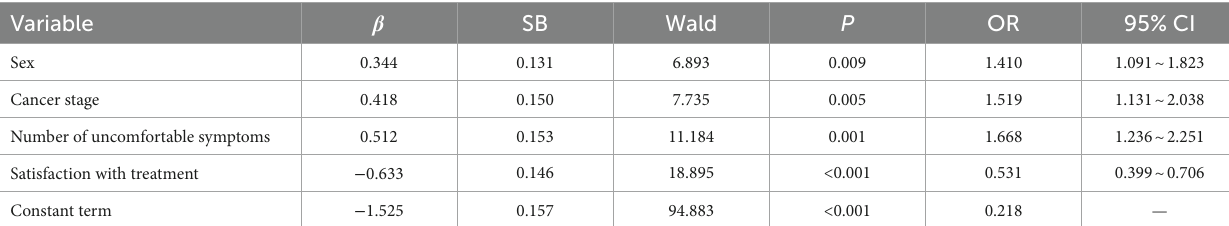
TABLE 3 Logistic regression analysis of factors independently associated with suicidal ideation in lung cancer